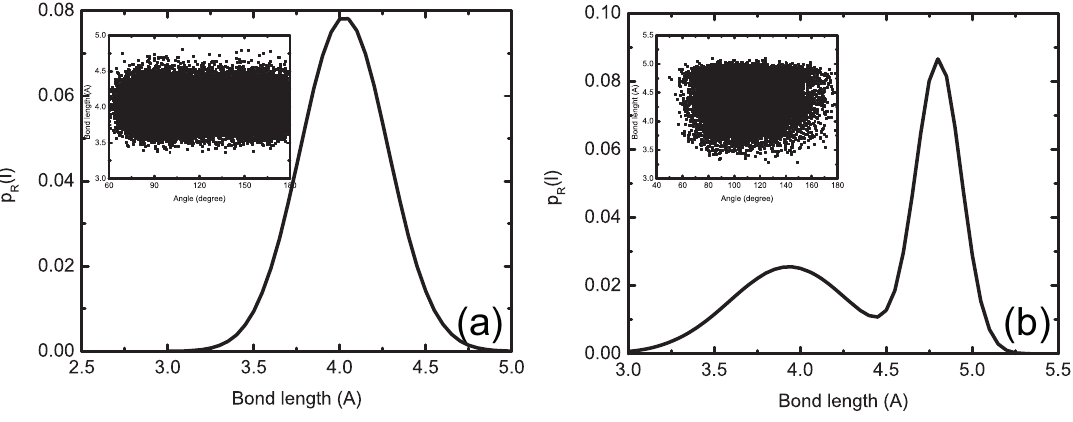
Figure 10. Bond-length distribution functions for a super atom of cis-PI defined ( a ) at the center of a carbon-carbon single bond connecting two monomers and ( b ) at the center of the monomer. The inserts show the bond-length versus bond-angle